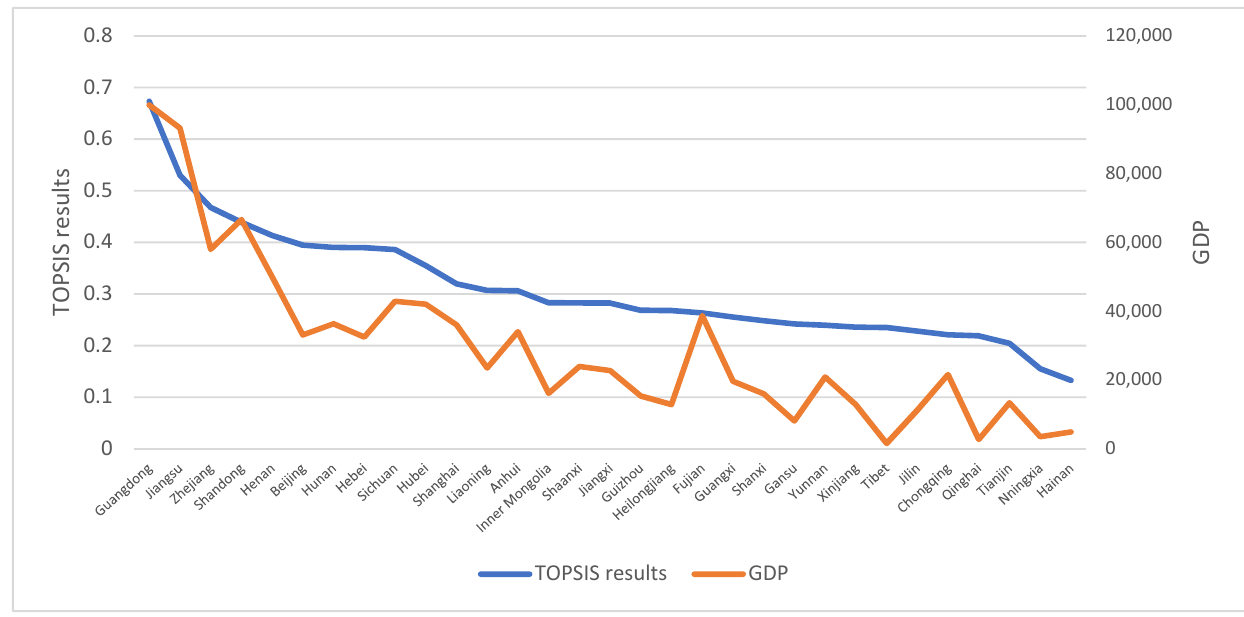
Figure 3. Comparisons on RIC and GDP of provinces in China.